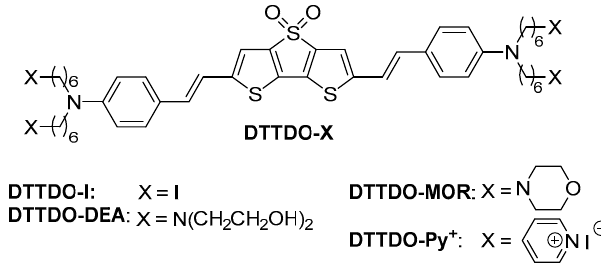
Figure 2. Structures of synthesized DTTDO derivatives.